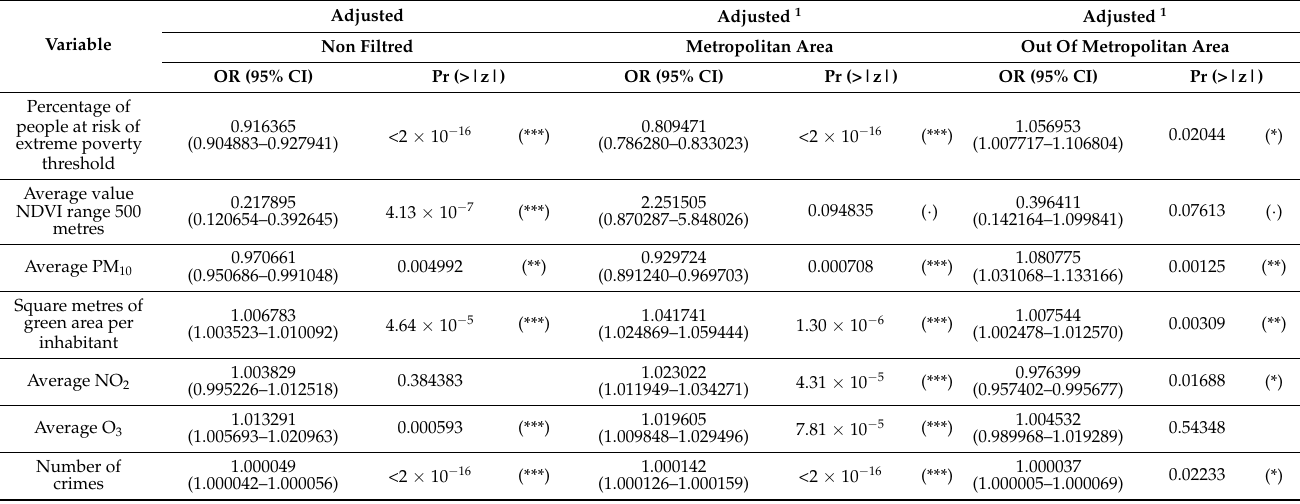
Table 4. Association between air pollutants and socioeconomic and health variables and the possibility of not renting a home for a family at risk of social exclusion by